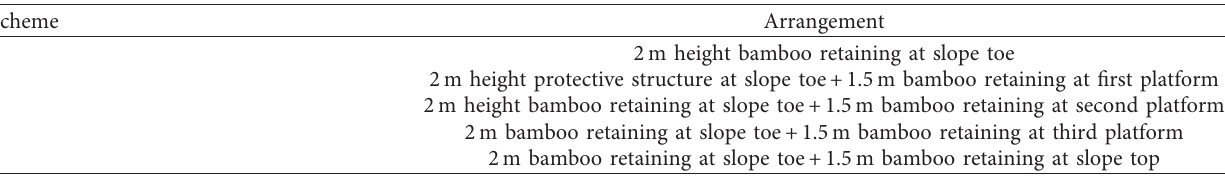
Table 1: Rockfall protection scheme.